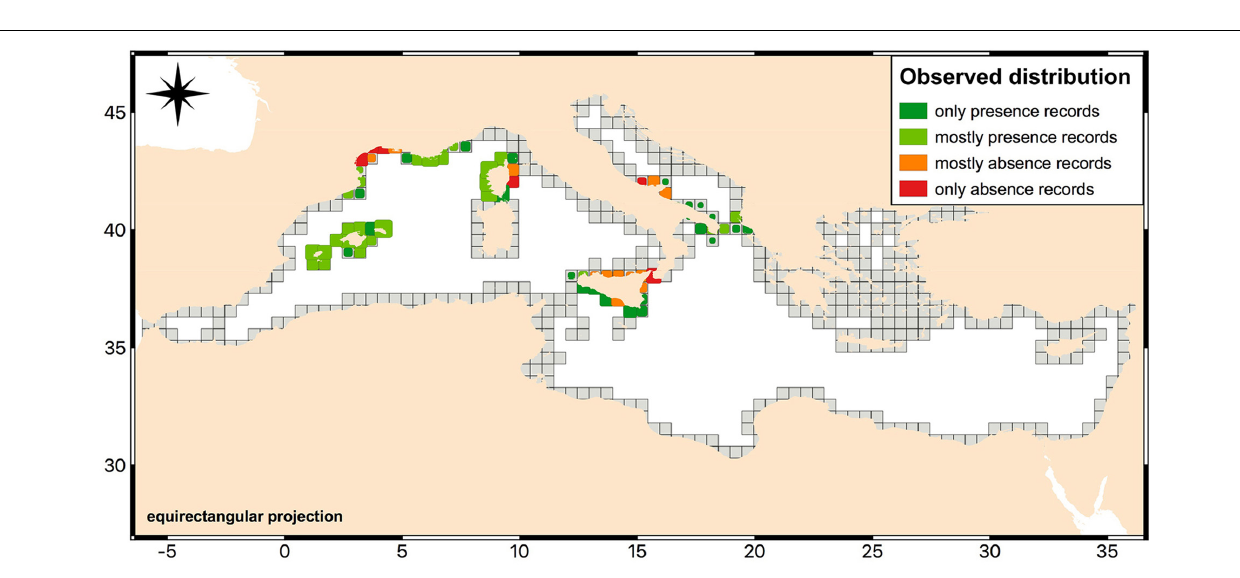
FIGURE 2 | Observed distribution of records of Cystoseira infralittoral species used in order to develop the HSM. The map shows only the areas where both presence and absence information were available. The colors used reflect the ratio between presence and absence data per cells. The dimension of cells is representative of the amount of available data. Map created with QGIS software (QGIS Development Team, 2018. QGIS Geographic Information System. O3.Open Source Geospatial Foundation: